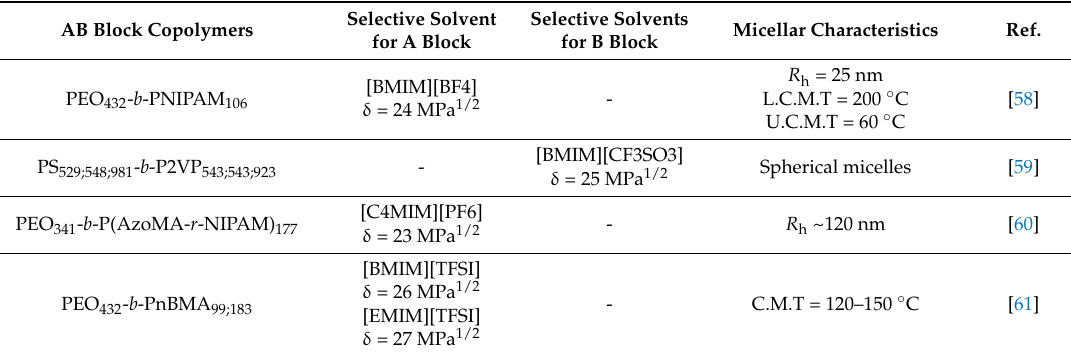
Table 4. Self-assembly studies of AB block copolymers in pure ionic